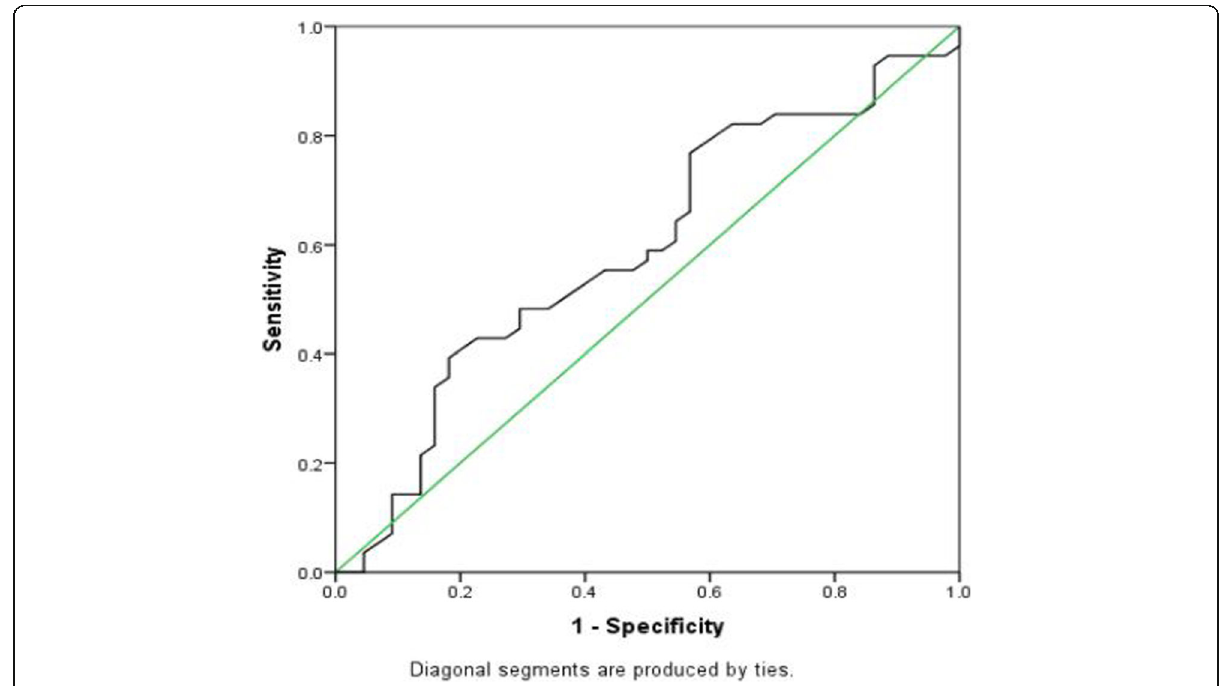
Fig. 1 ROC curve analysis for fibulin-5 as a predictor of cerebrovascular stroke outcome